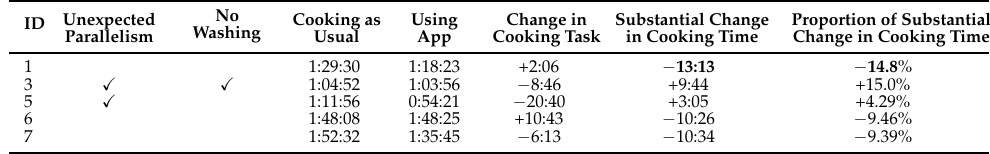
Table 5. Result of experiment for each user (Group A).